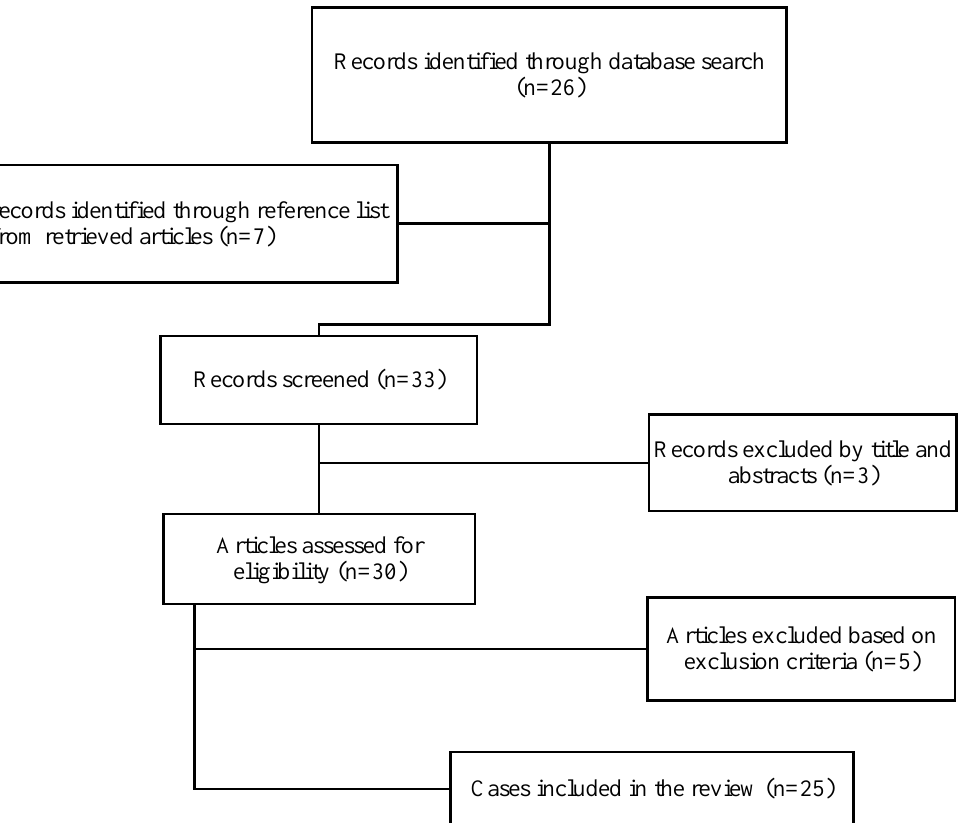
Figure 1. Workup for selecting relevant papers selected from the PubMed, Google Scholar, and Web of Science databases.